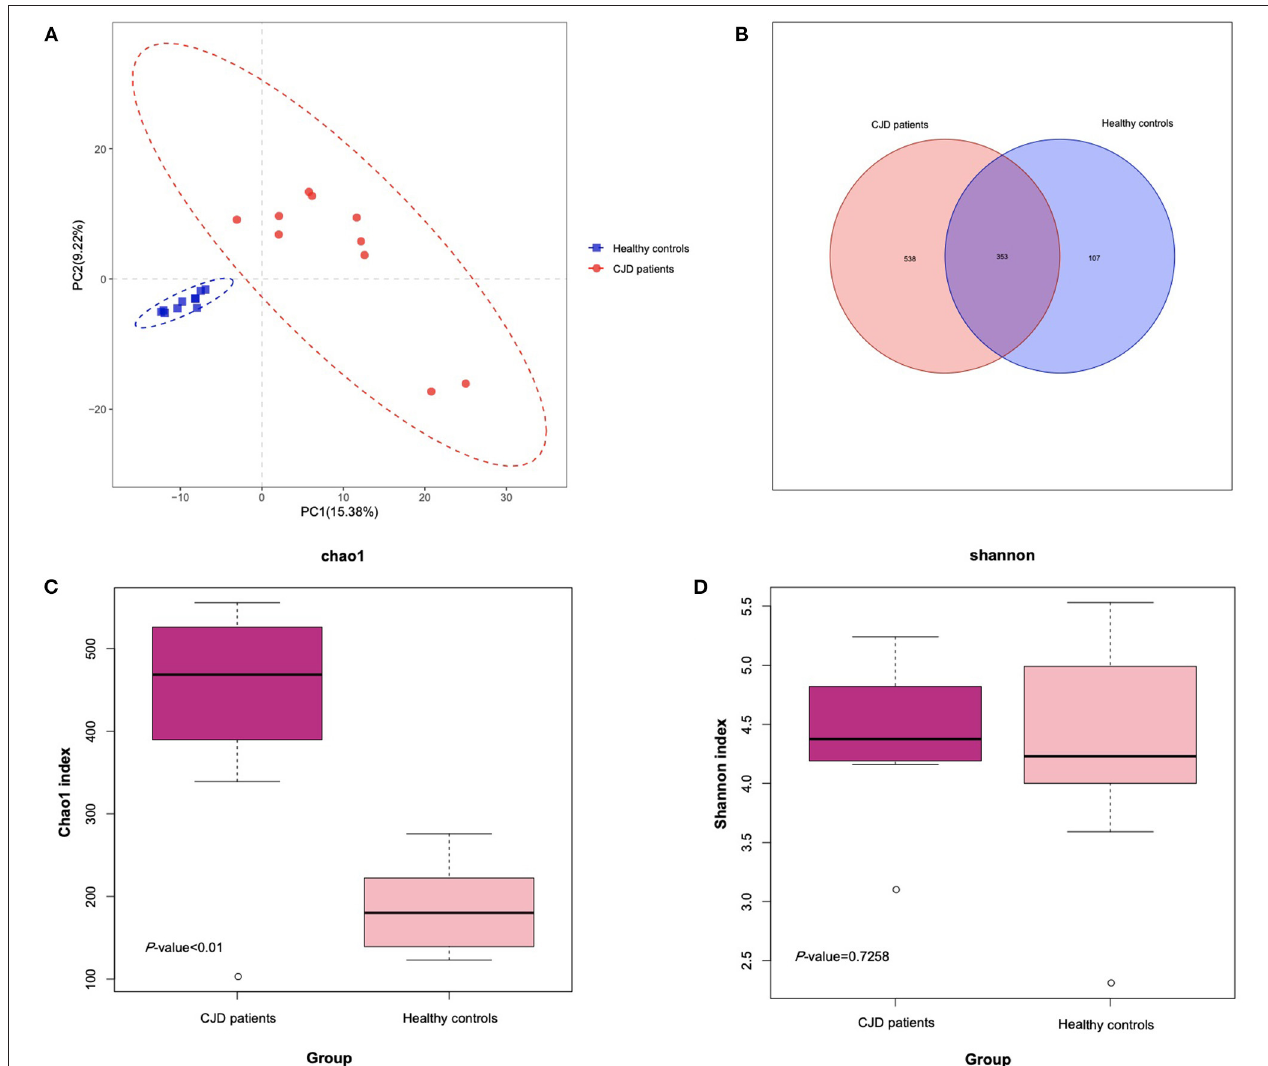
FIGURE 1 | Comparison of the microbial diversity of patients with CJD and control. (A) PLS-DA analysis of the patients with CJD and control using R software. The CJD group and control group were separated without overlap, suggesting a distinct gut microbiota community in CJD and control groups. (B) Venn diagram illustrates the OTUs’ overlap of fecal samples from CJD and control. (C) Box plot illustrates significant difference ( p < 0.05) of Chao1 index in the 2 groups. Median, interquartile range, minimum, and maximum values are shown in the box plot. (D) Box plot illustrates nonsignificant difference ( p = 0.73) of Shannon index in the 2 groups. Median, interquartile range, minimum, and maximum values are shown in the box